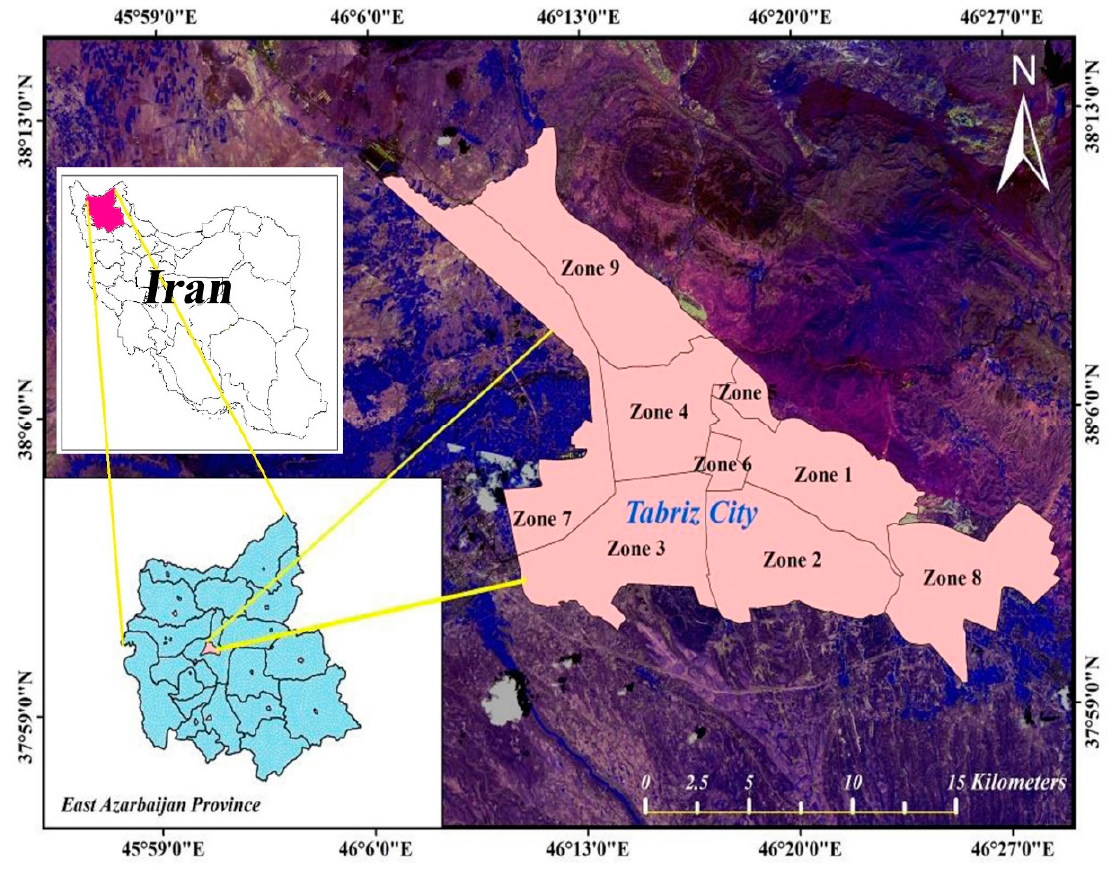
Figure 1. Geographical location of Tabriz in Iran and its municipal zones.